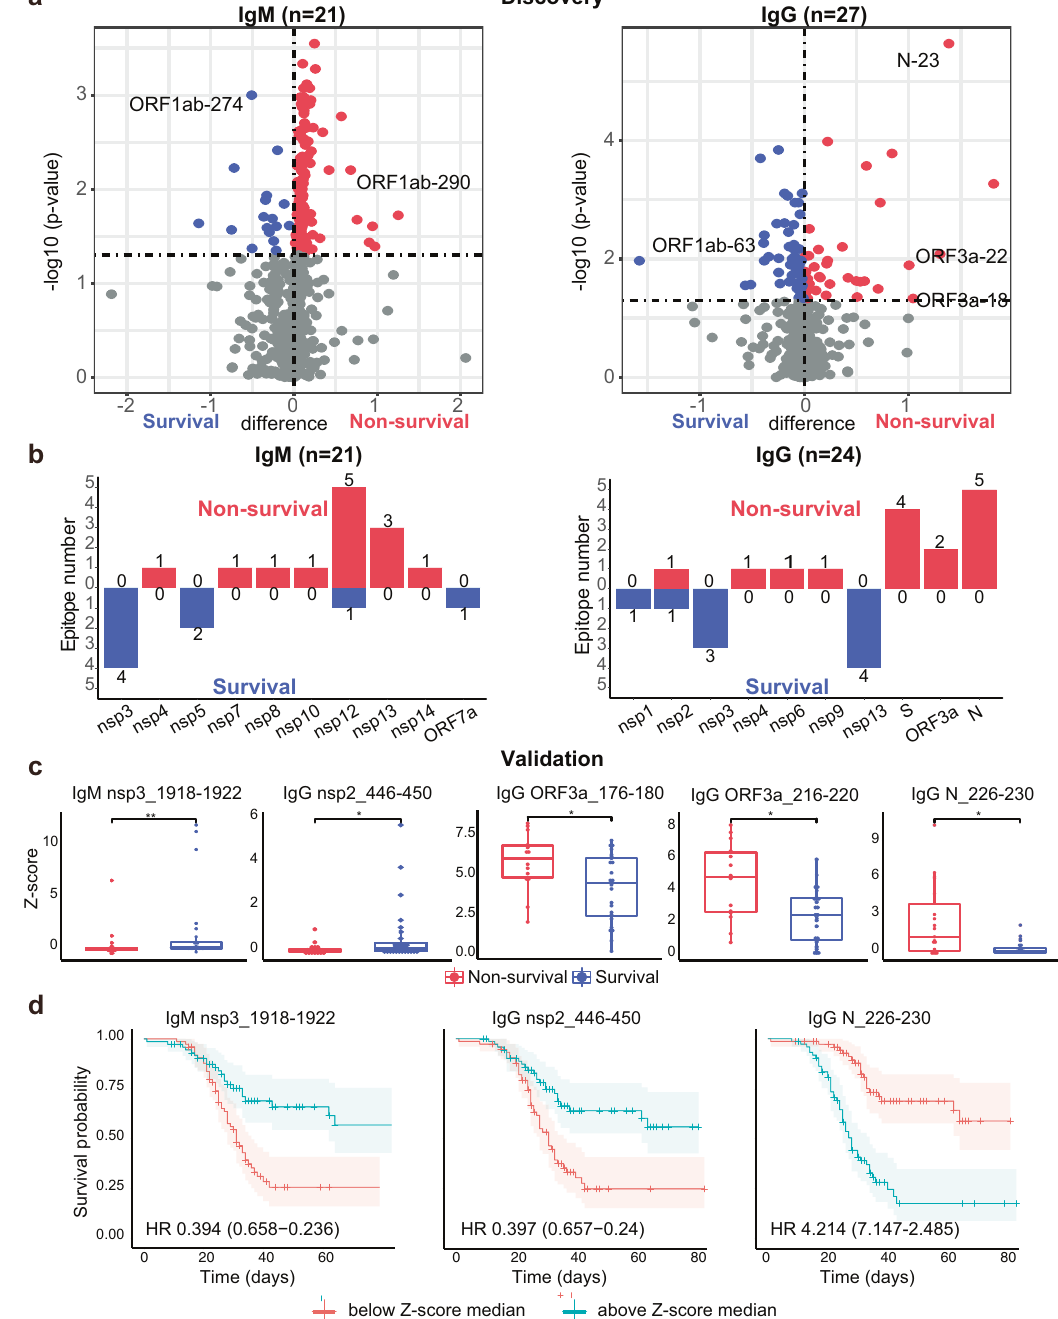
Fig. 7 Association between SARS-CoV-2 antibodies and the survival of critical COVID-19 patients. a , b Identi fi cation of SARS-CoV-2 IgM and IgG antibodies associated with the survival and non-survival of critical COVID-19 patients, respectively. The antibody candidates were identi fi ed using a t -test with a p -value < 0.05 and an immunogenicity with a z-score > 1.96 in ≥ 3 serum samples. b IgM and IgG peptide epitopes within SARS-CoV-2 proteins associated with the survival and non-survival of COVID-19 patients, respectively. c Validation of epitopes associated with survival and non-survival in an independent serum cohort. d Kaplan – Meier curve analyses of SARS-CoV-2 antibodies as potential risk factors of COVID-19 mortality. The Kaplan – Meier curves show the survival probability of patients with high versus low antibody levels since symptom onset. Grouping criteria (cutpoints) are provided in the graphs. Hazard ratios (HR) for high versus low antibody levels are provided with p-values from log-rank tests methylase complex), replication and transcription (RdRp), poly- Many of the IgM and IgG epitopes identi fi ed in this current study protein processing (nsp3 PLpro domain, nsp5 proteases) while include residues that are critical for nsps to maintain their also helping to activate the host ’ s innate immunity (nsp1, nsp3 functions (Figs. 3d, 4 – 6). Thus, the host immune response may ADRP domain) (Figs. 3 – 6, Supplementary Figs. 4 – 5). 31,44,45 The defend against SARS-CoV-2 infection by generating antibodies that inhibit viral invasion (S), RNA protection (nsp10/nsp16 2 ′ -O- hypothesis can be supported by the nanobody that targets the Signal Transduction and Targeted Therapy (2021)